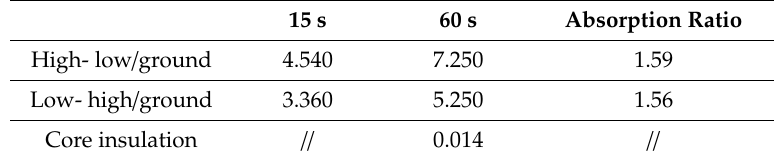
Table 9. Insulation resistance test (G Ω ).